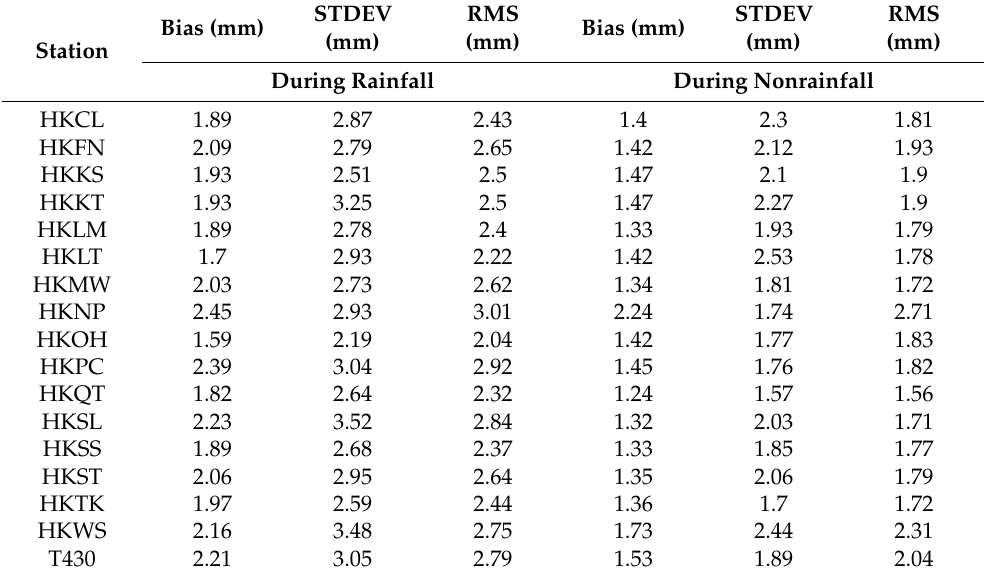
Table 8. Bias, STDEV, and RMS between PPP PWV and NWP